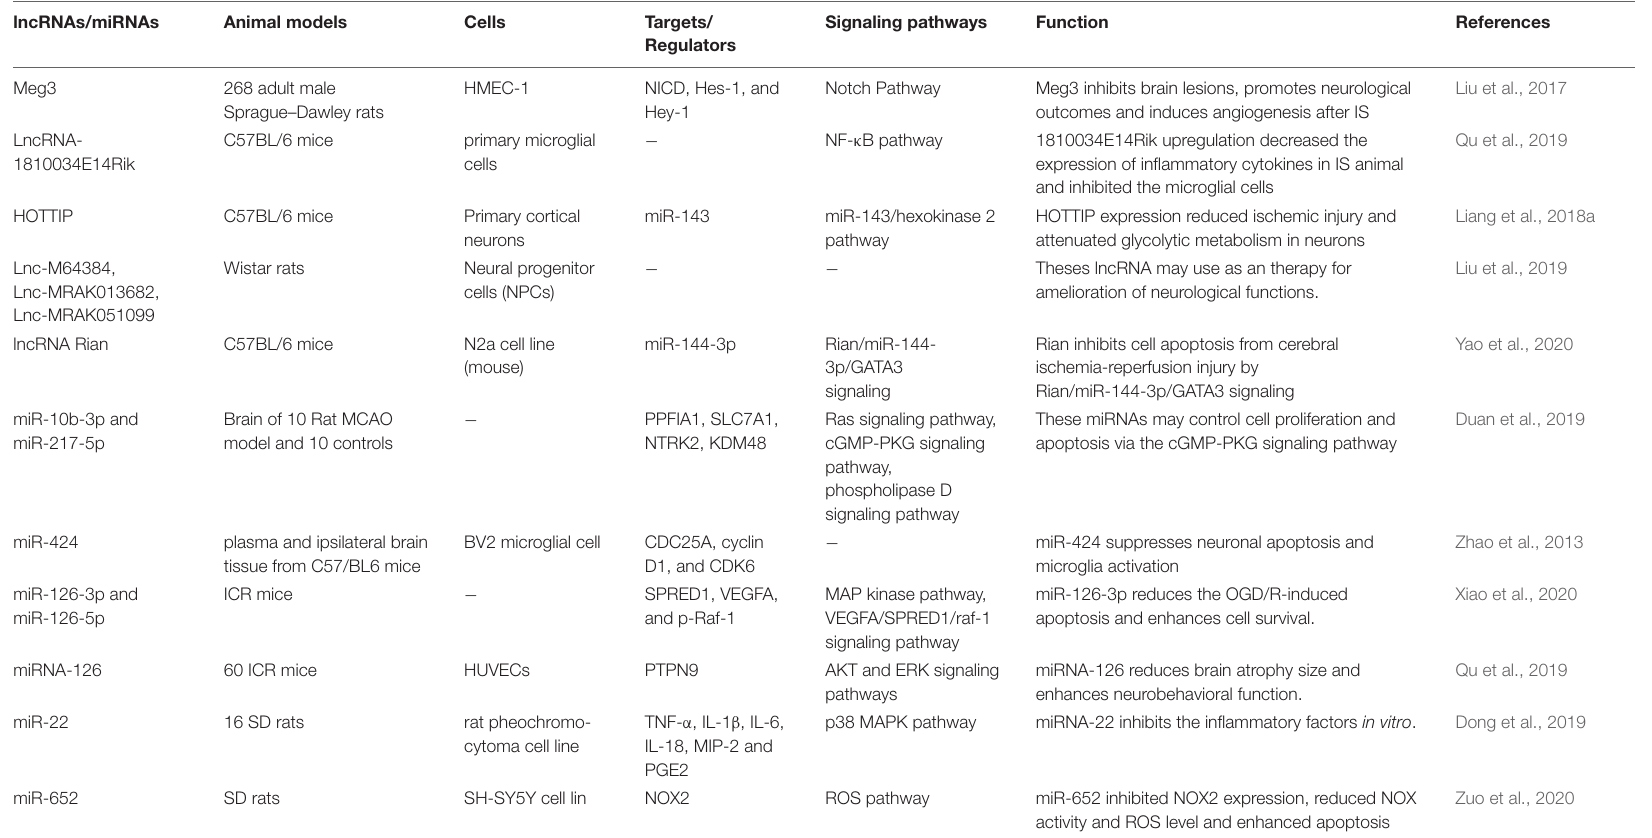
TABLE 8 | Summary of animal studies which displayed down-regulation of lncRNAs and miRNAs in stroke.